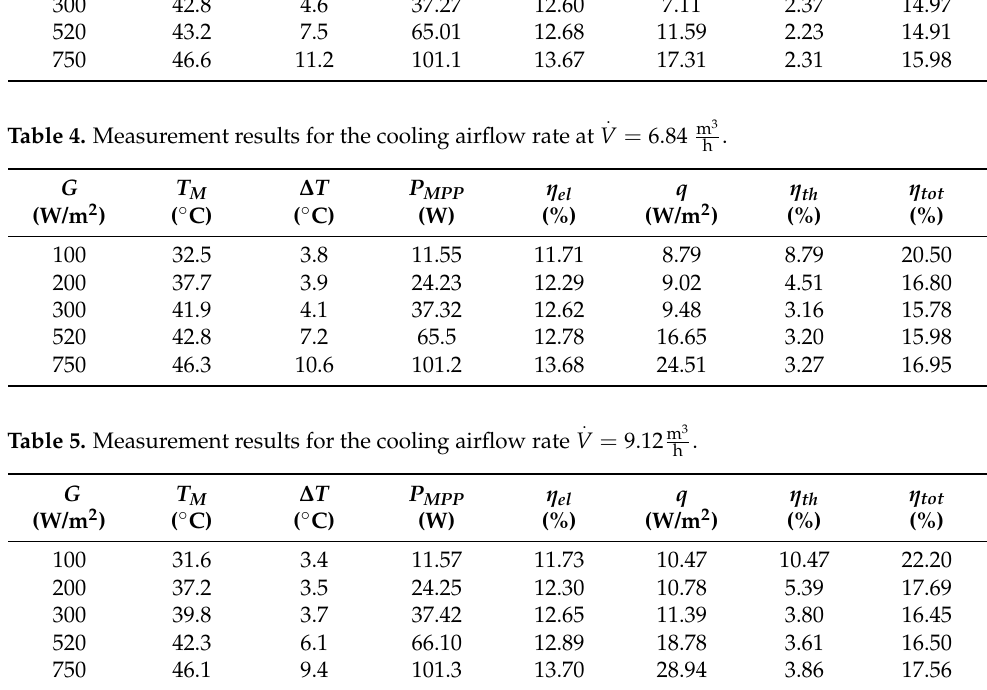
Table 4. Measurement results for the cooling airflow rate at 𝑉(cid:4662) = 6.84 (cid:2923)